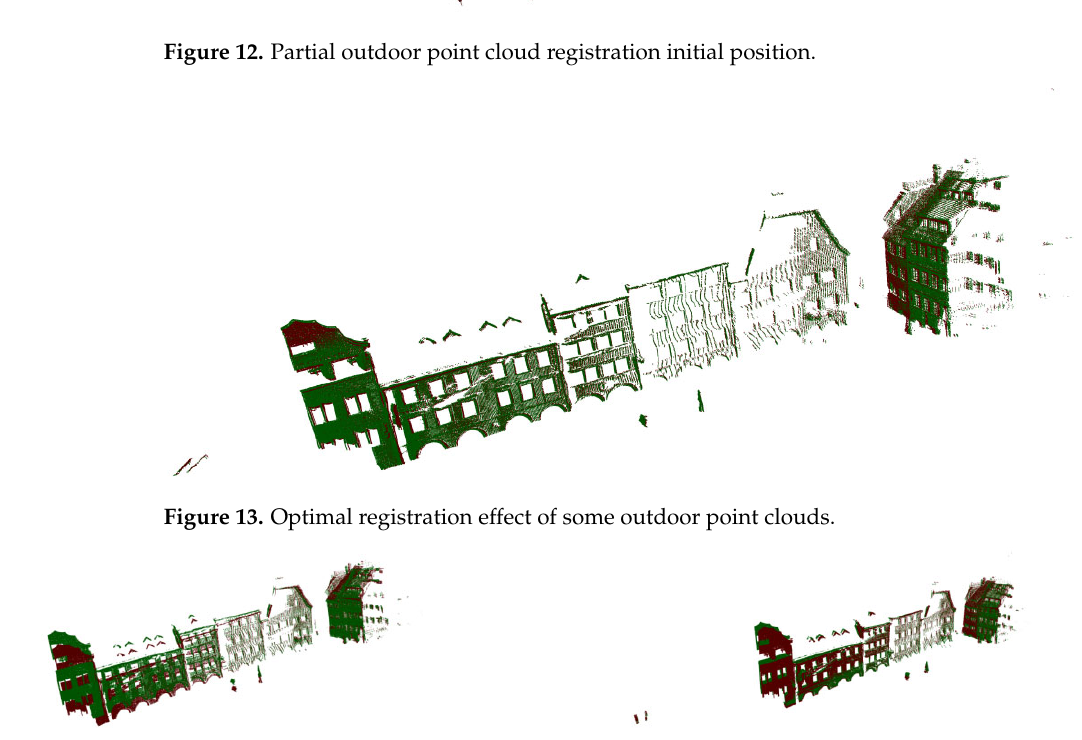
Figure 13. Optimal registration effect of some outdoor point clouds.